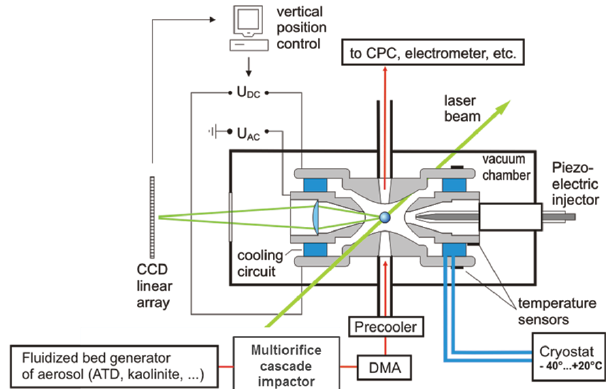
Fig. 3. Experimental